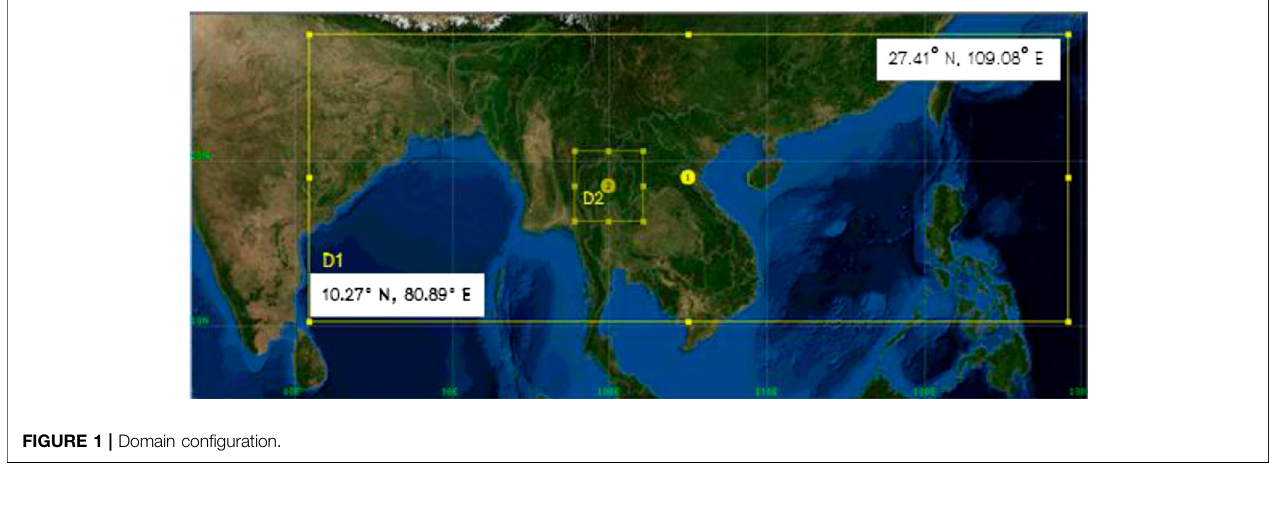
FIGURE 1 | Domain con fi guration.